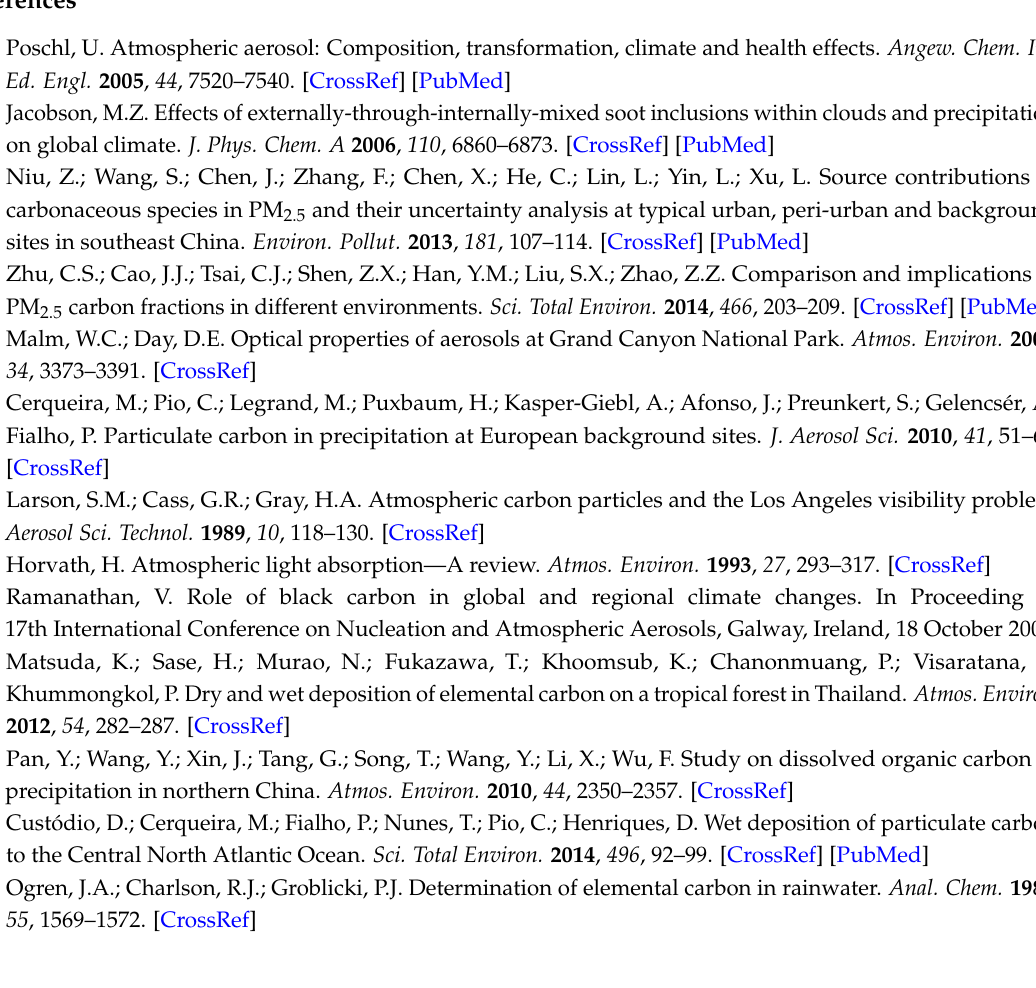
Figure S1: Daily backward trajectories arriving at the sampling site (a) on May 23 and (b) August 13, Figure S2: Four clusters of the air mass backward trajectories arriving at the sampling site, in which cluster 1 of 4 represents the trajectories of T_1, cluster 2 of 4 represents the trajectories of T_2, cluster 3 of 4 represents the trajectories of T_3, and cluster 4 of 4 represents the trajectories of T_4, Figure S3: Time series of daily BC mass concentrations at Xiamen Island during the study